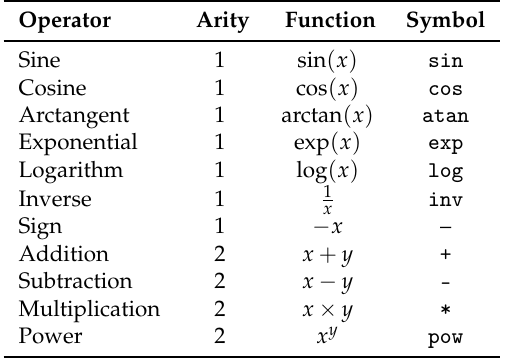
Table 1. Mathematical operators included in the evolutionary process.